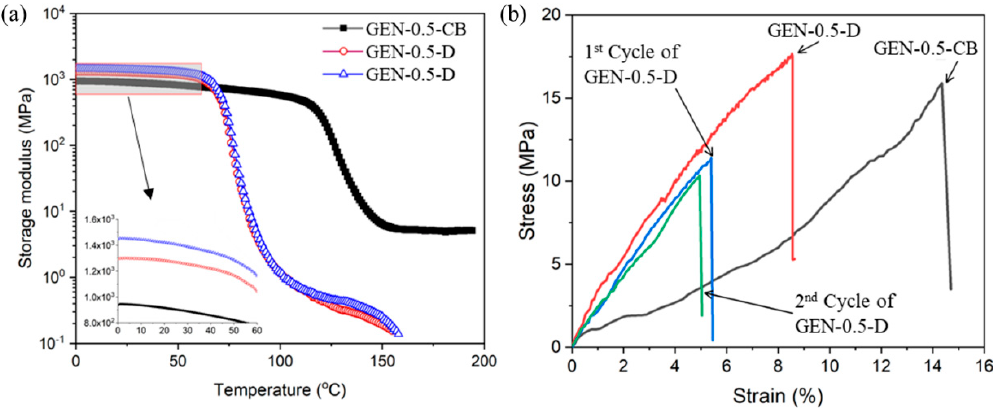
Figure 8. ( a ) Storage modulus of control B epoxy resin (CB) and D system composites, ( b ) Repeated recycling test results for GEN-0.5-CB and GEN-0.5-D.